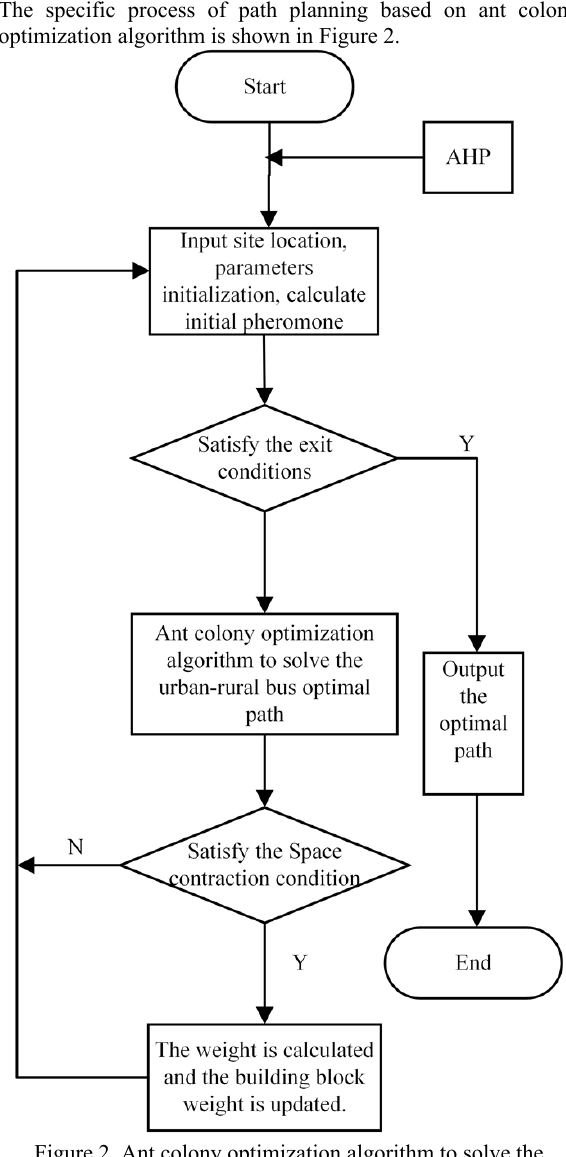
Figure 2. Ant colony optimization algorithm to solve the optimal path flow chart for the urban-rural